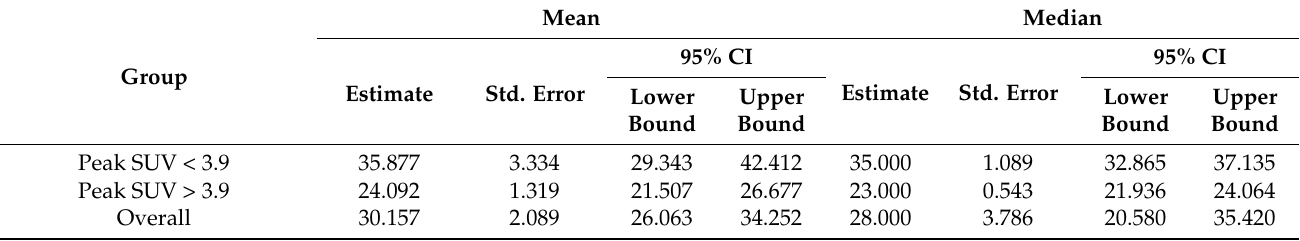
Table 3. Survival time means and medians.